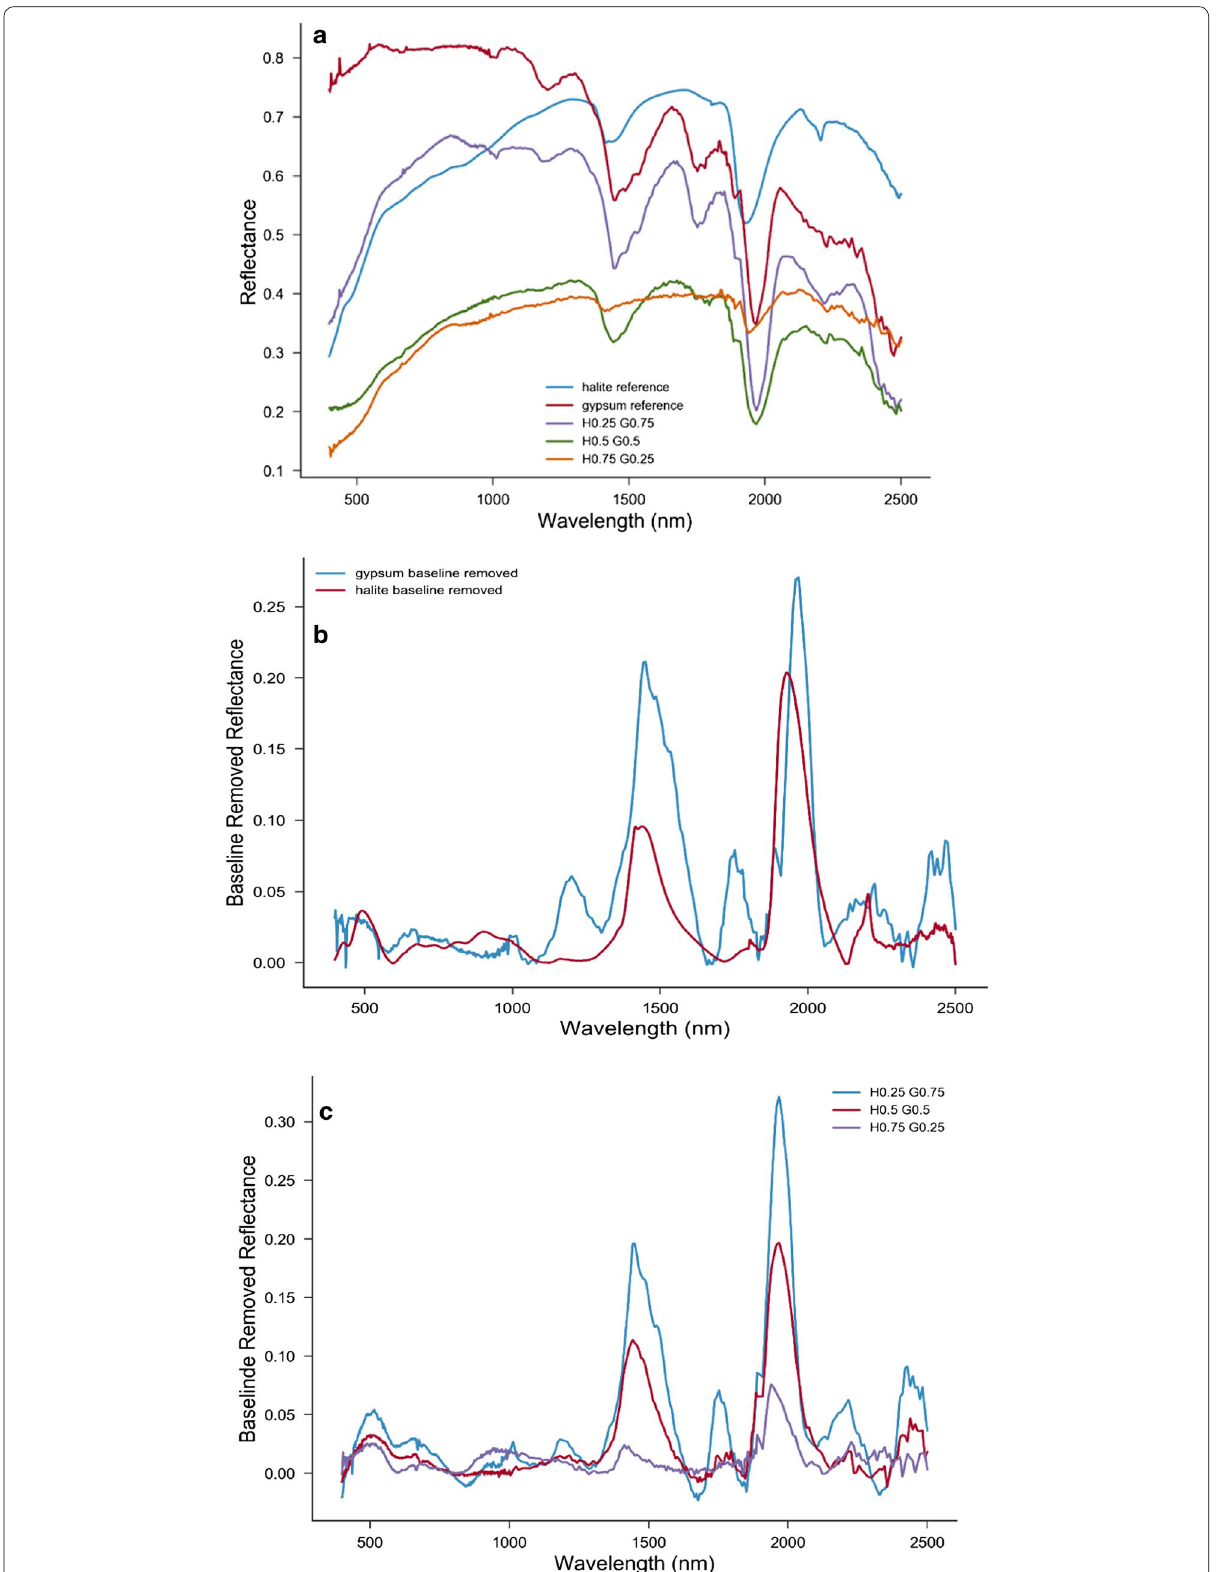
Fig. 3 Spectra of gypsum and halite with their mixtures ( a ) in comparison of their continuum free spectra ( b , c